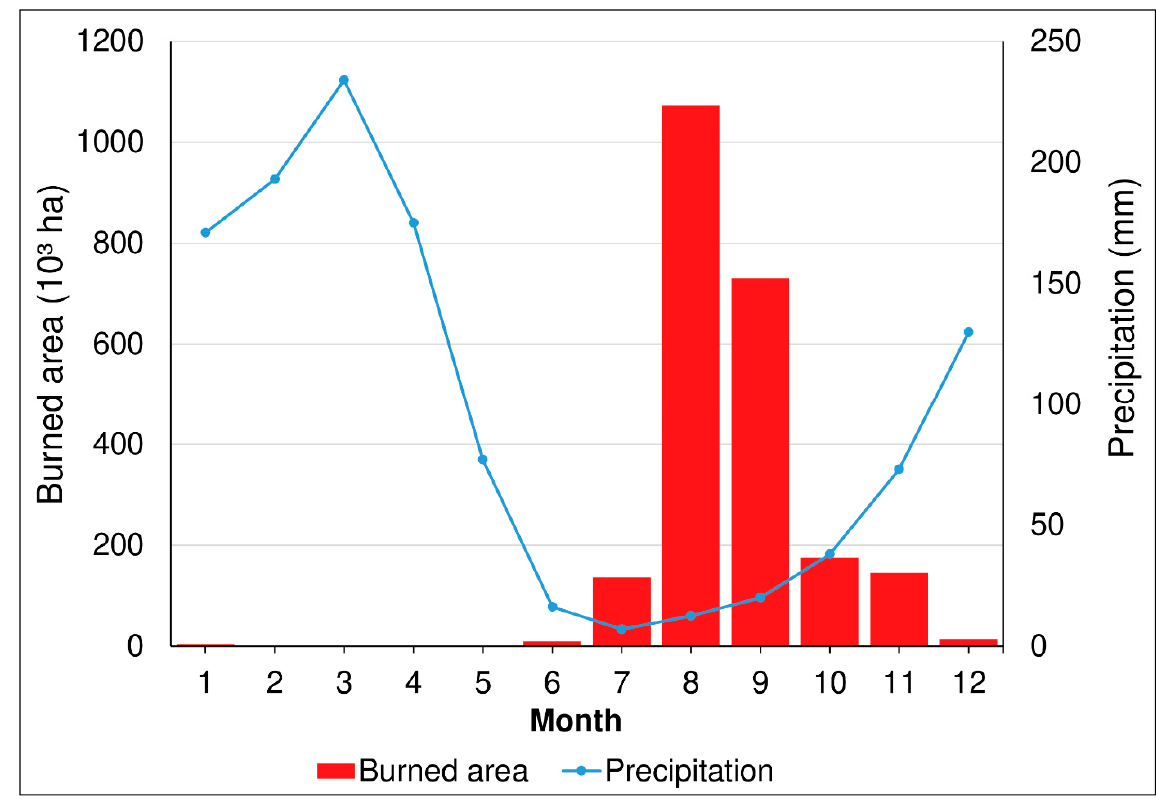
Figure 6. Number of burn scars by month (red bars), together with mean monthly precipitation in the ILs and the surrounding areas (blue line).